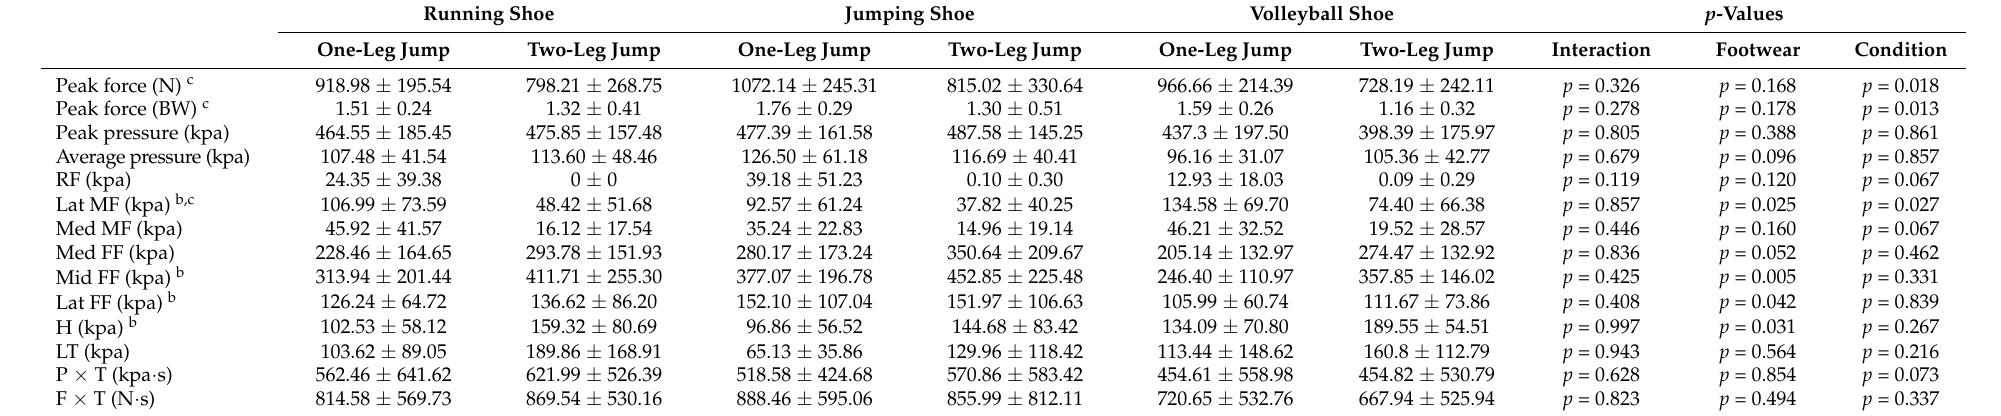
Table 2. The descriptive statistics (Mean ± SD) and statistical result of plantar pressure variables during jump rope